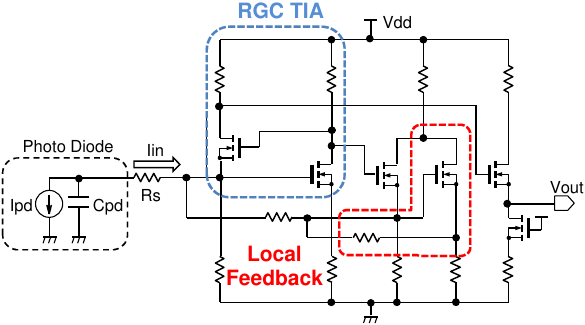
Figure 3. Proposed TIA with local feedback.